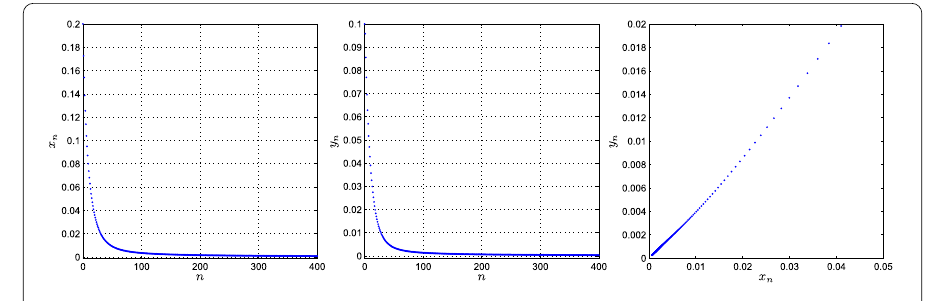
Figure 3 The states and phase space of the controlled